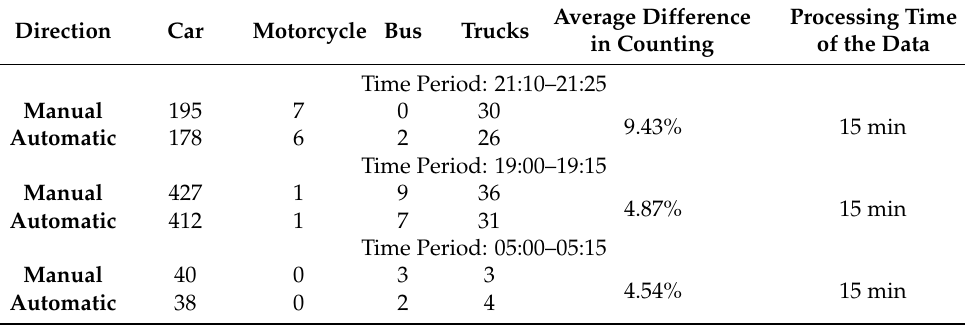
Table 4. Results obtained from camera count in the different time periods.